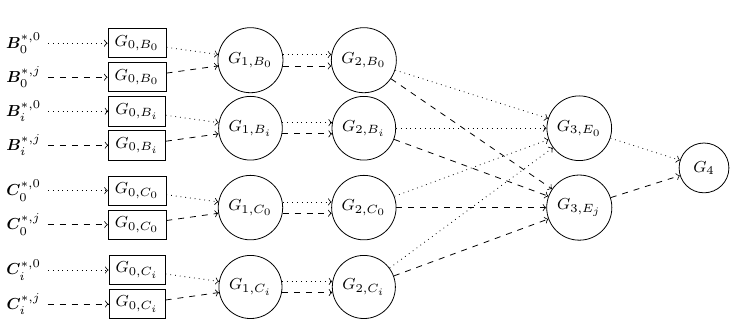
Figure 2: Overview of Gadgets in Algorithm 7. Different line types correspond to different shares.